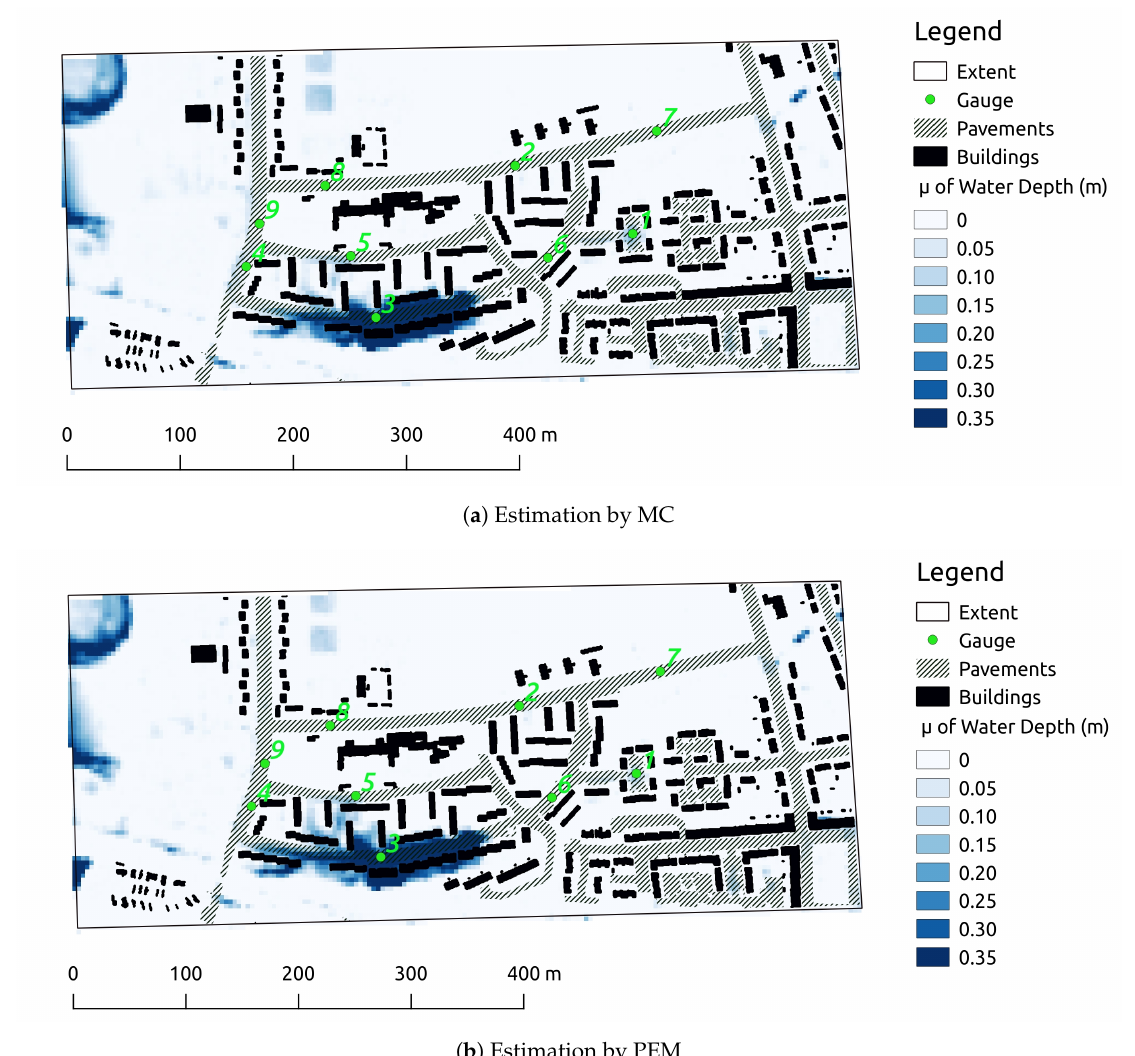
Figure 7. Map of the 1st statistical moment of maximal water